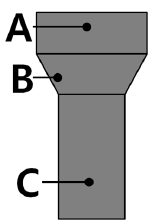
Figure 4. Three positions for microstructure and Vicker’s hardness determination of extrusion billets.